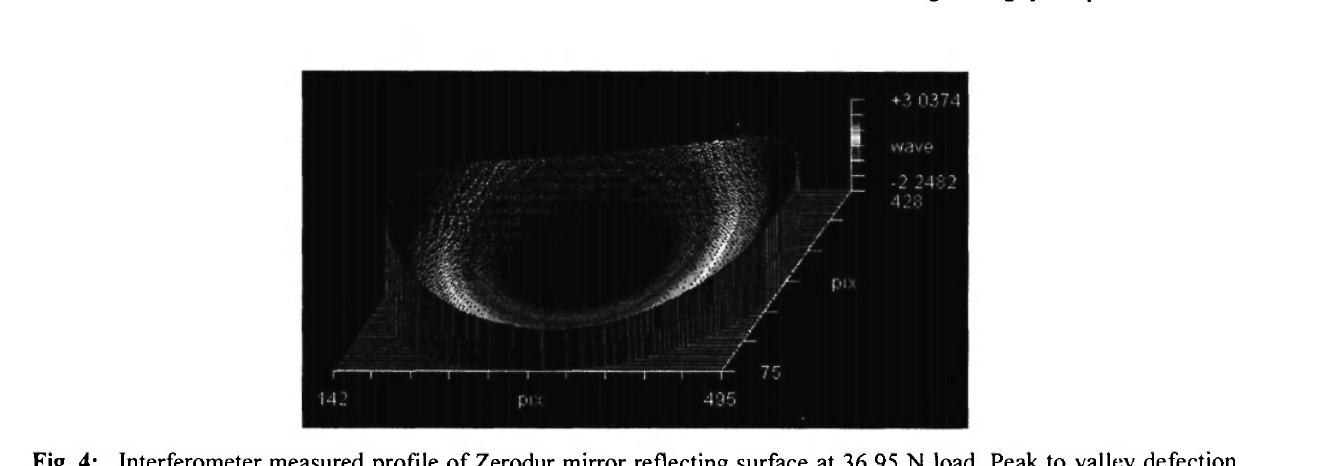
Fig. 4: Interferometer measured profile of Zerodur mirror reflecting surface at 36.95 Ν load. Peak to valley defection of 3.037 +2.248 = 5.285 χ wavelength of laser or 3.345 μηι.